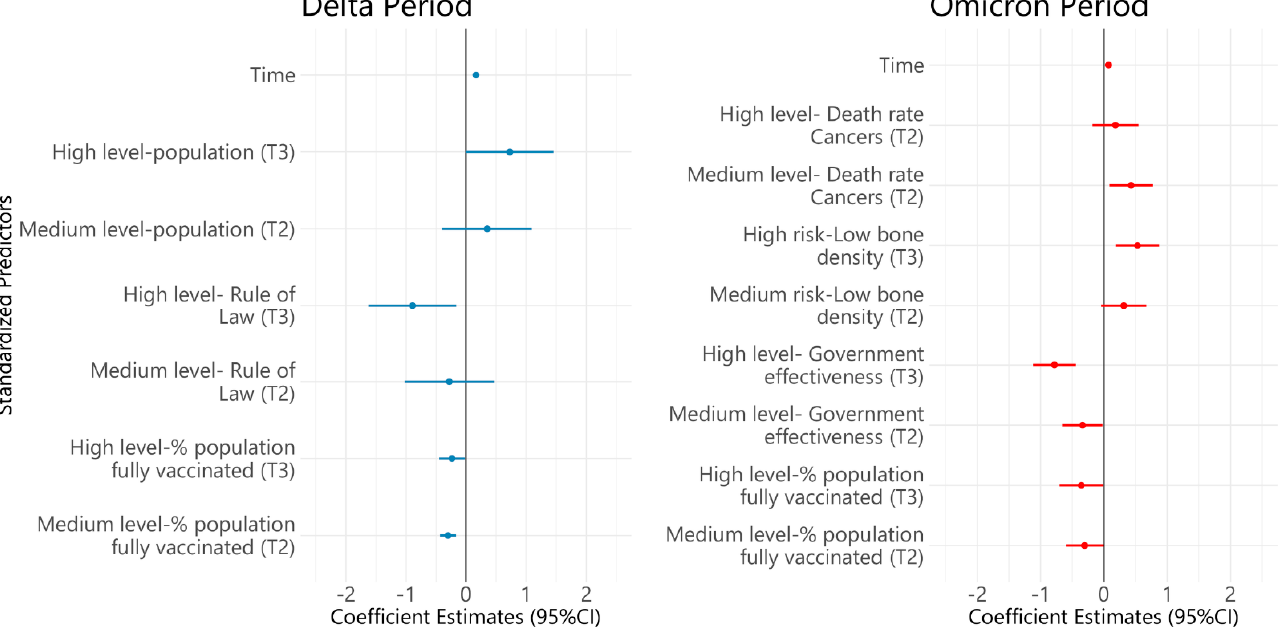
Figure 5. Multivariate linear mixed effect models of factors associated with the resilience index.